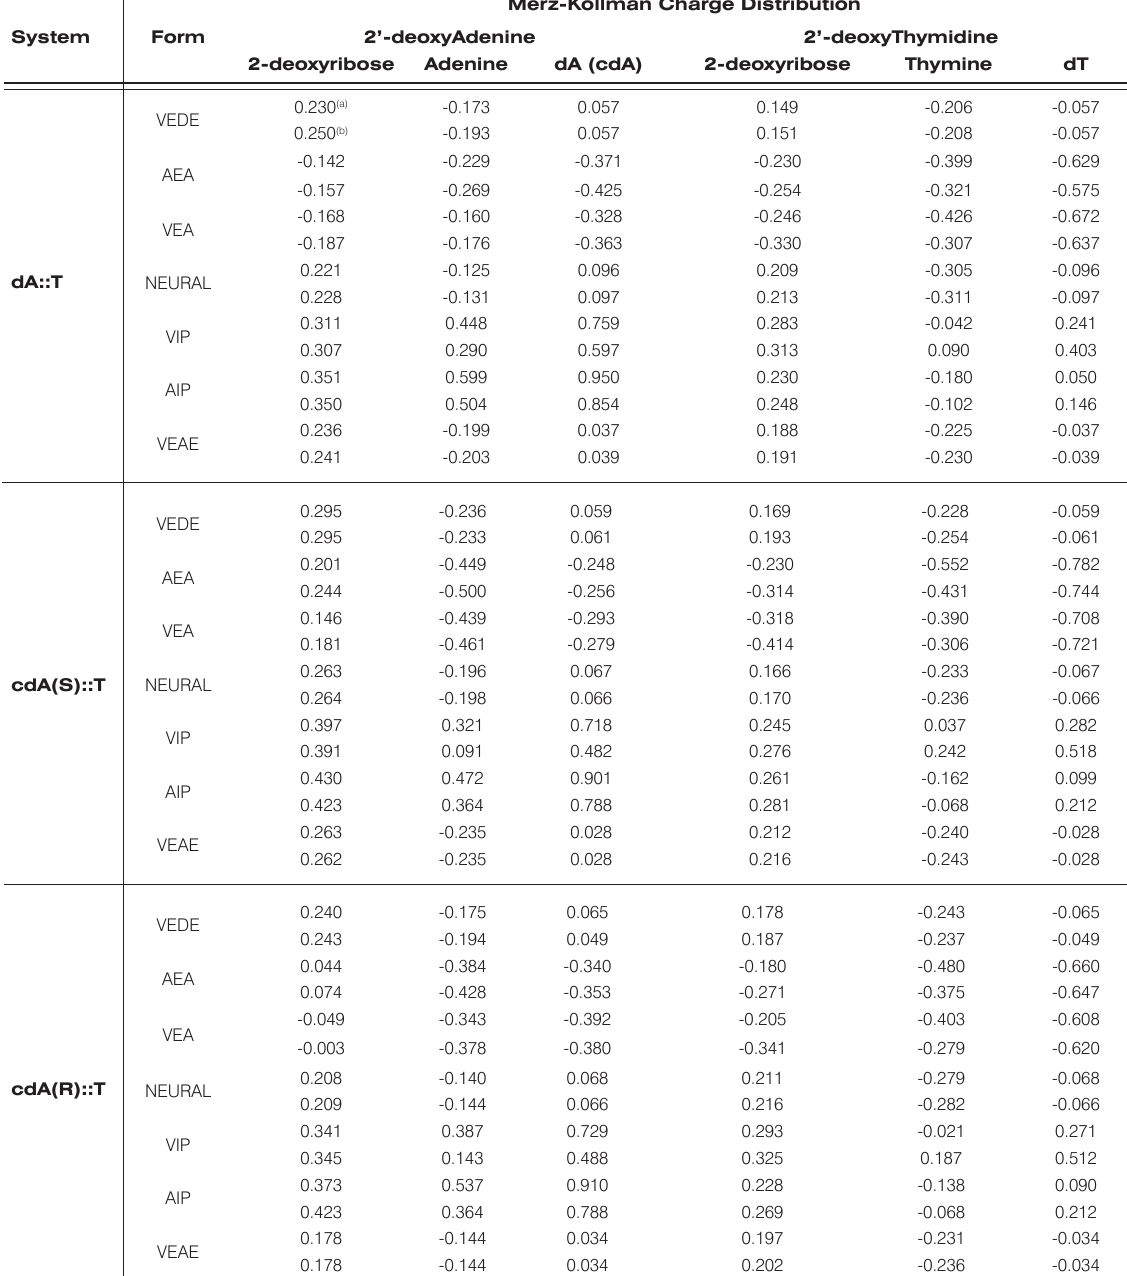
Table 2. Charge distribution in cdA(S)::T , cdA(R)::T and dA::T nucleoside pairs during electron attachment / detachment. Merz-Kollman Charge